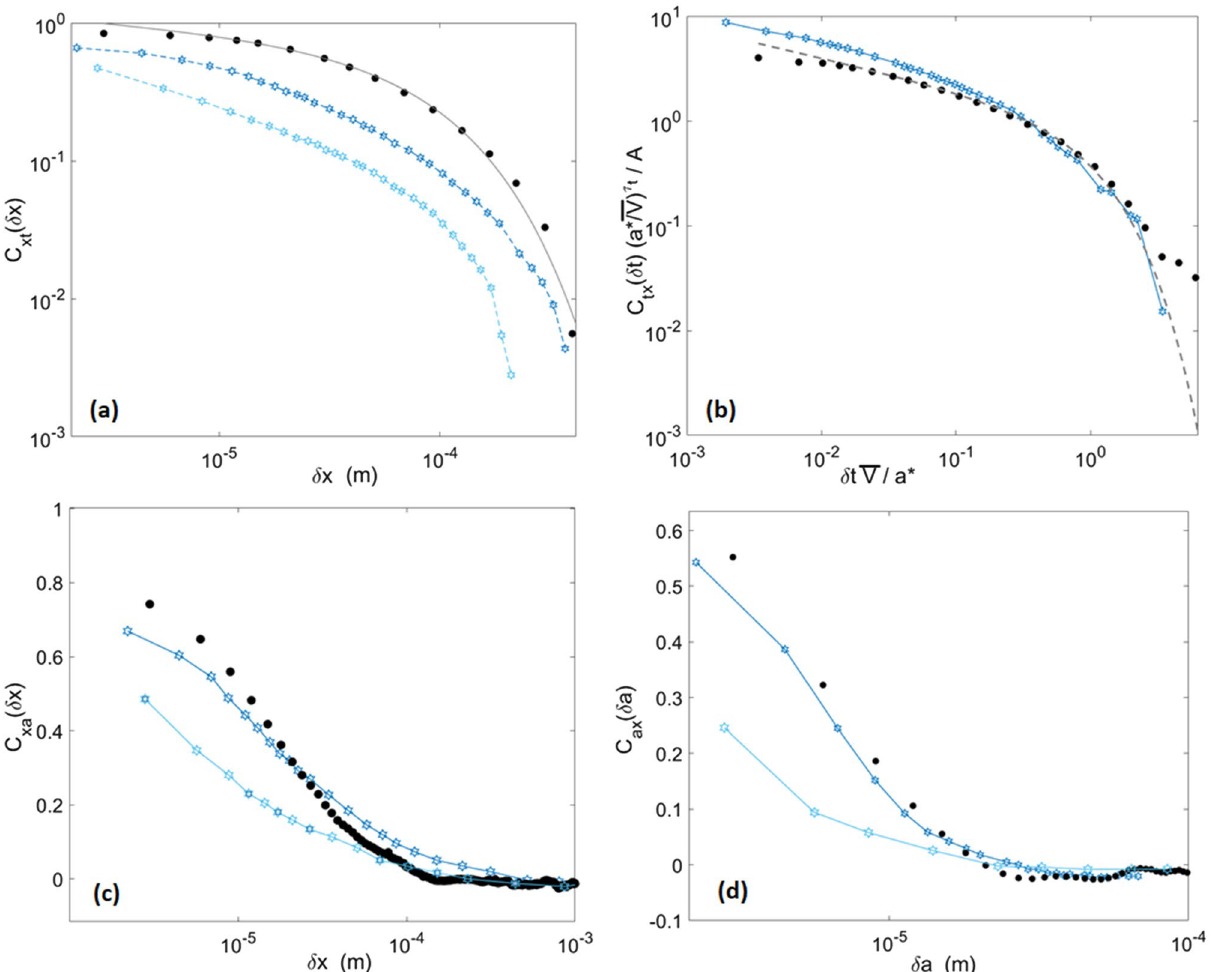
Figure 6. Local velocity correlation functions in space and time as defined by Eq. (7). The plain points were computed from the simulation whose parameters are presented in Table 1 and the hollow stars are some of the experimental data points extracted from Figs. 6 and 7 of Tallakstad et al. 28 . In plot ( a ), the line overlying the numerical data set corresponds to a fit using Eq. (8). ( b ) is plotted in a domain that allowed a good collapse of the experimental data for many experiments 28 . The parameters A , a ∗ and τ t were inverted from Eq. (9), and the related fit is shown by the dashed line overlying the numerical data set. Plots ( a , c , d ) hold two curves for the experiments, corresponding to two distinct sets of experiments done on two different sintered PMMA bodies. ( b ) Shows Expt. 5 of Tallakstad et al. 28